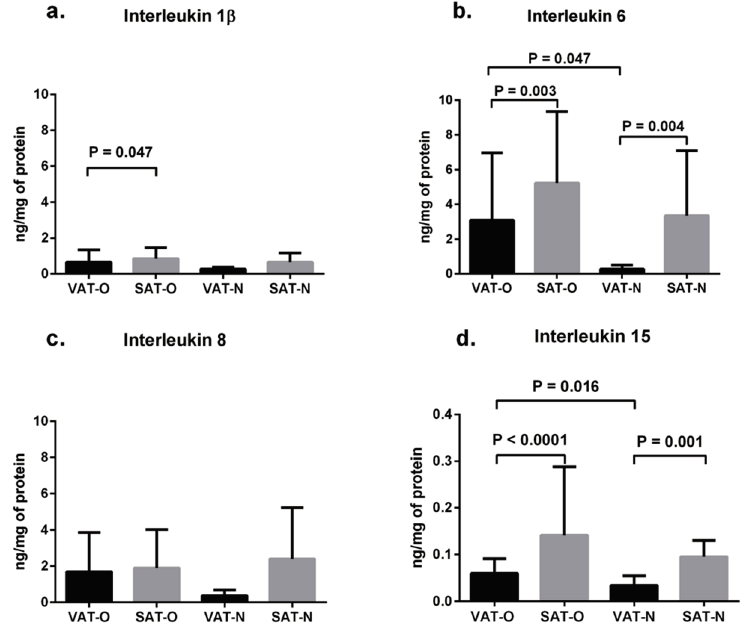
Figure 1. Mean protein levels of interleukin 1 β ( a ); interleukin 6 ( b ); interleukin 8 ( c ) and interleukin 15 ( d ) in the visceral (VAT) and subcutaneous (SAT) adipose tissues of obese (O) and normal-weight (N) individuals. Results are shown as mean ± standard